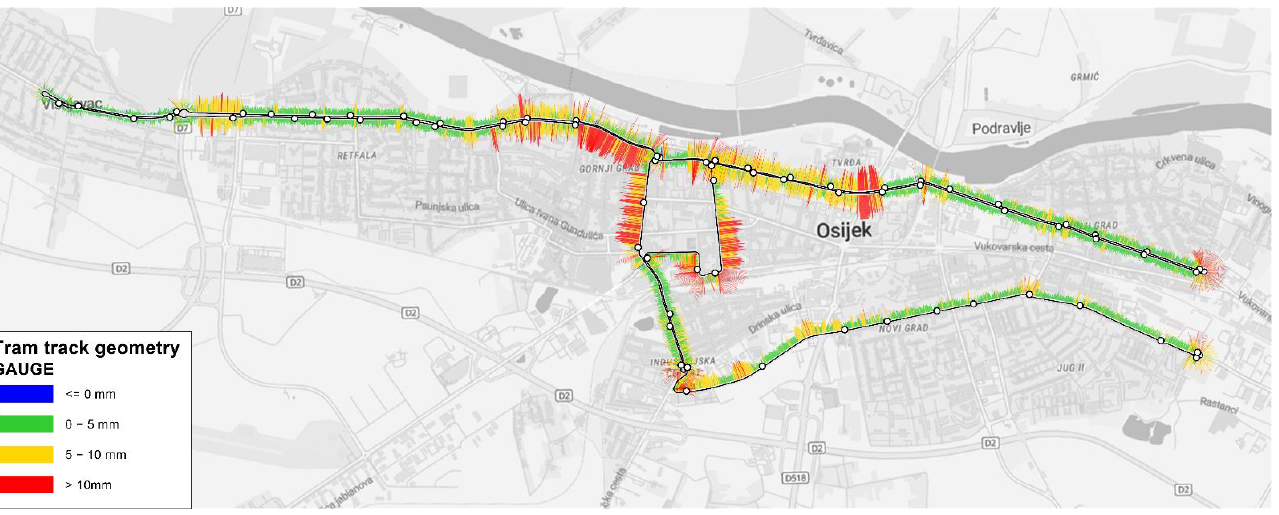
Figure 5. Tram track gauge parameter values.